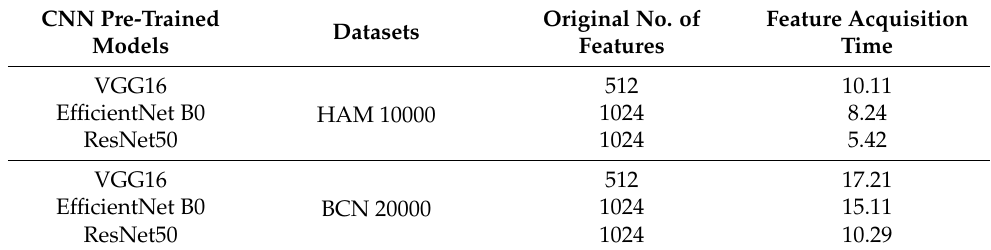
Table 3. Feature acquiring time.